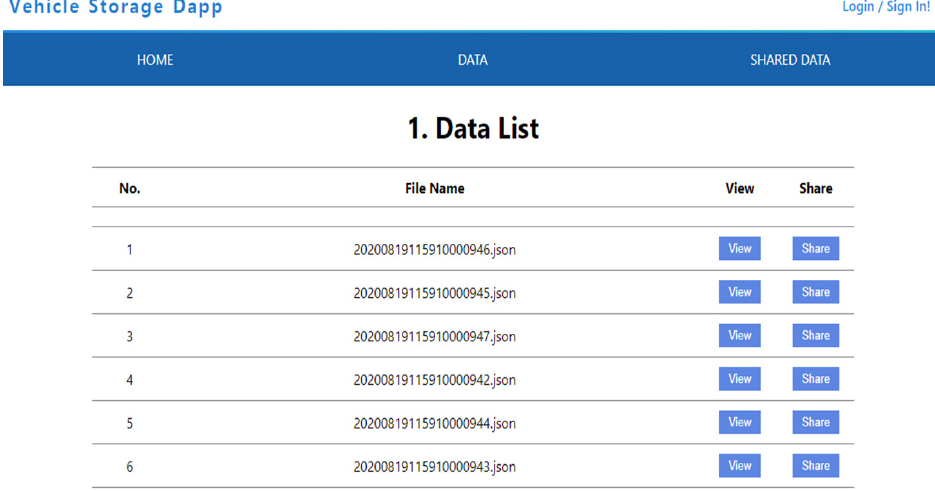
Figure 7. Data page. In the data page of Figure 7, the user can check the list of file data stored in his FileList contract, and when clicking the View button, the data access process is requested, and the data can be viewed. When the user clicks the share button, they are taken to the sharing